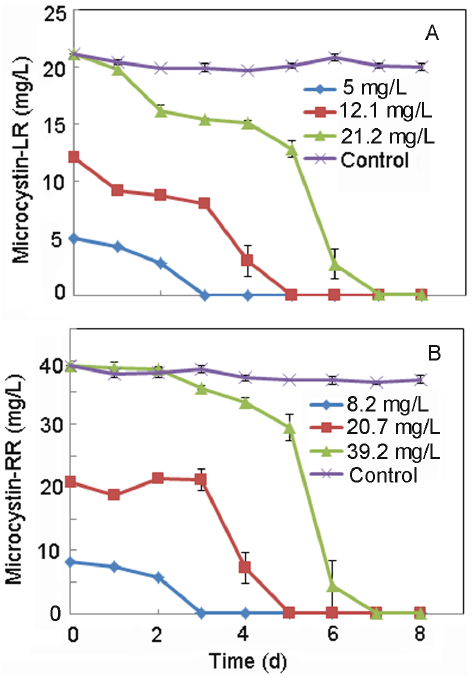
Figure 4. Effect of initial microcystin concentration on the degradation of MC-LR (A) and MC-RR (B) by